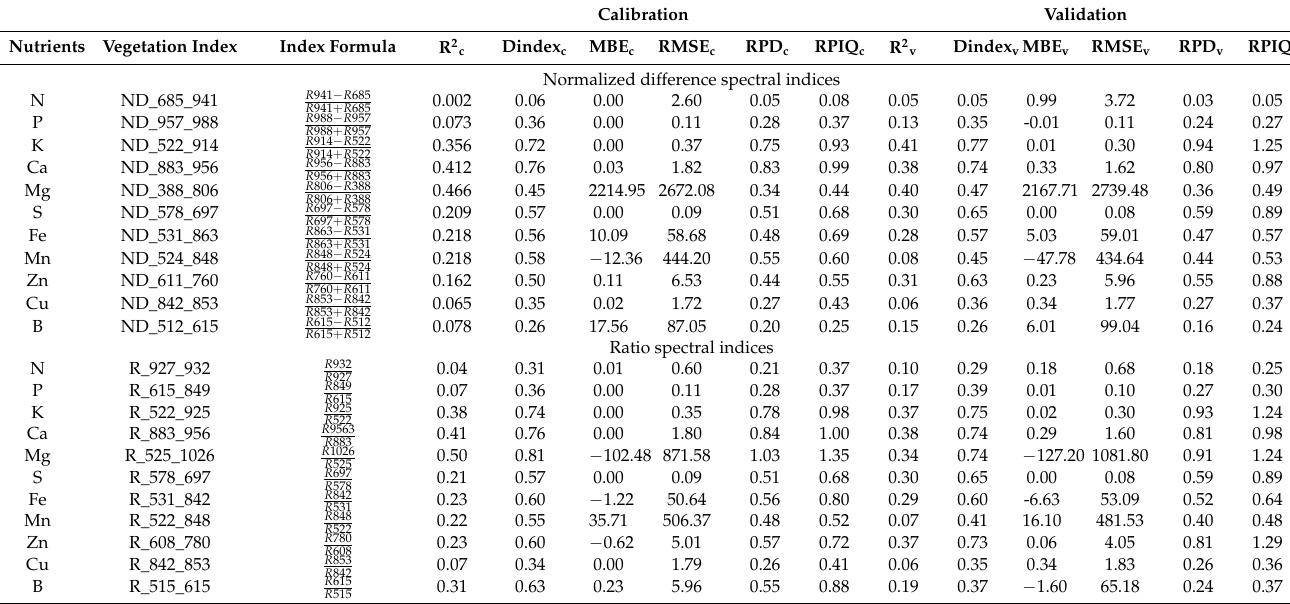
Table 3. Performance of the best-identified normalized difference and ratio vegetation indices to predict the leaf nutrient